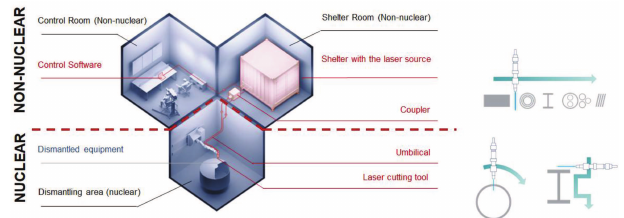
Fig. 1. LASER cutting typical configurations for decommis- sioning